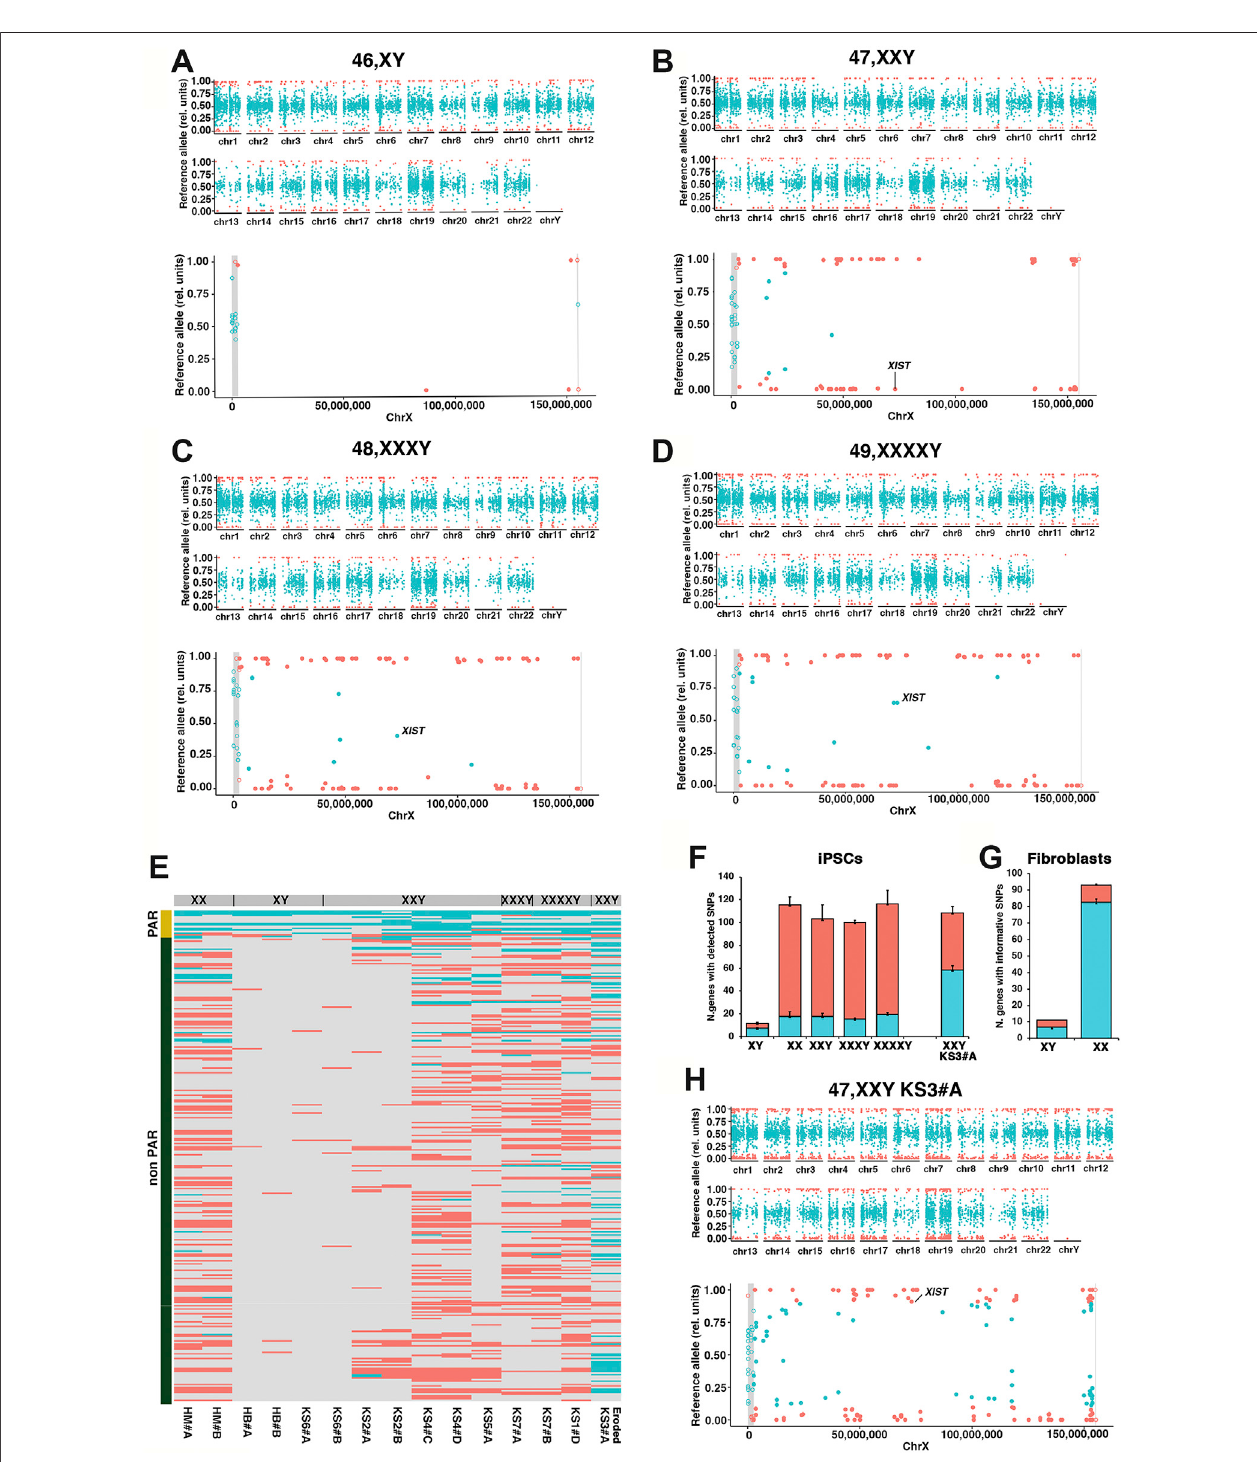
FIGURE 2 | Allele-speci fi c expression (ASE) pro fi les of cases and controls iPSCs highlighting the tight retention of X chromosome inactivation. (A – D) Scatter plot pro fi les of coupled WES analysis and allele-speci fi c RNA-Seq analysis performed on autosomal (upper panel) and X chromosomes (lower panel) showing the mono- (orange dots) or biallelic (light blue dots) gene expression status in four representative karyotypes. Gray rectangles indicate PAR1 and PAR2 regions, respectively. Solid dotsindicatenon-PARgenes;opendotsshowPARgenes. XIST allele-speci fi cexpressionstatusisdisplayedforeachsample. (E) Heatmapofmono-(orange)and biallelically expressed (light blue) genes in the PAR and non-PAR regions for the indicated iPSCs. The nonparametric Mann-Whitney tests showed the statistically signi fi cantdifferencesbetweentheactive/inactivestatusofPARversusnon-PARgenes: p (cid:1) 1.57e-12forallgenotypes, p < 2.22e-16fortheKS3#AerodediPSCs. (F,G)